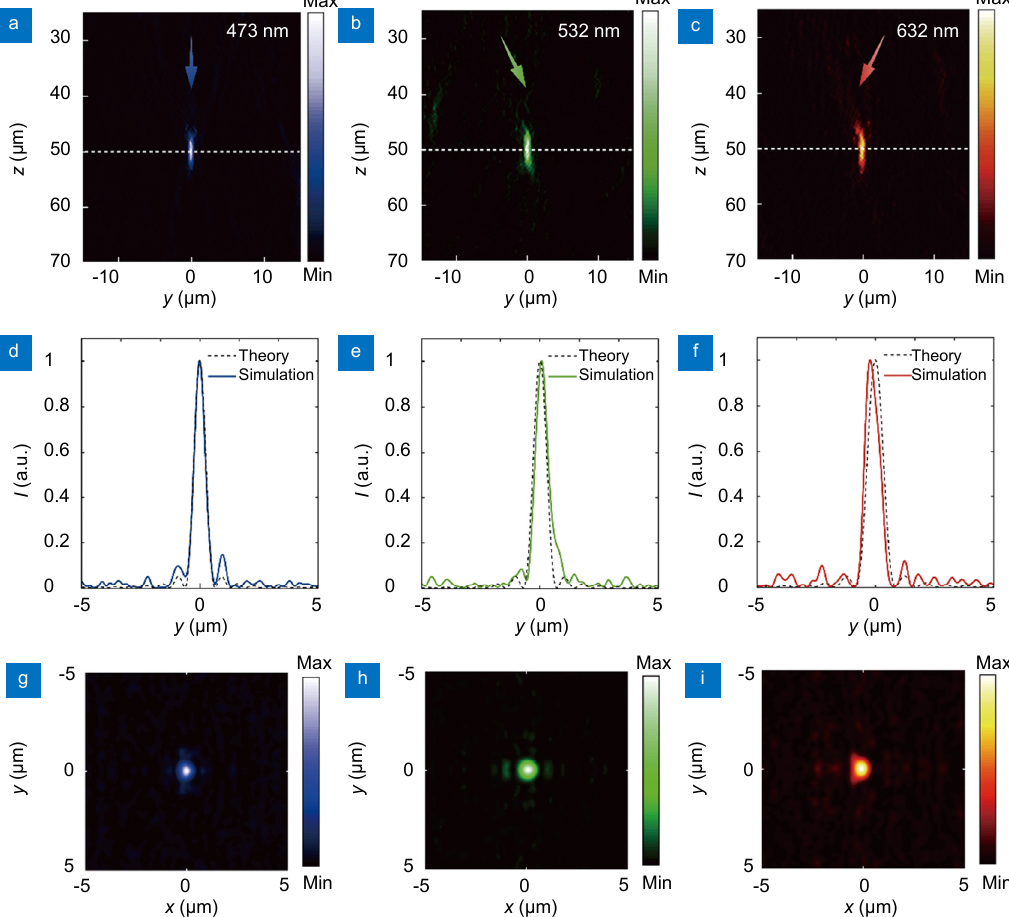
Fig. 4 | ( a–c ) Numerically calculated normalized intensity distributions in the yz -plane at the wavelengths of 473 nm, 532 nm, and 632 nm under TE polarized incidence. The corresponding incident angles are 0°, -17° and 17°, respectively. ( d–f ) Theoretical (dotted lines) and calculated (solid lines) normalized intensity curves of the three lights along the y -axis across the focal plane. ( g–i ) Normalized intensity distributions in the xy -plane at the focal plane for the wavelengths of 473 nm, 532 nm, and 632